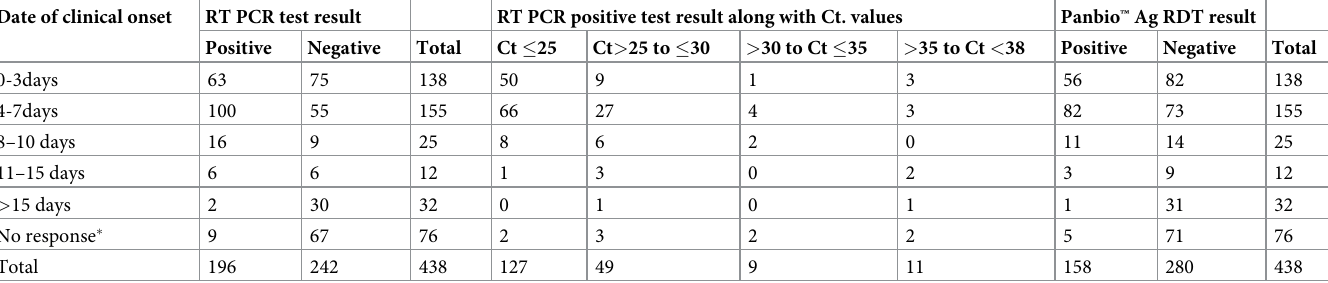
Table 2. RT-PCR and Panbio ™ test results in relation to days since clinical onset, 2021, Addis Ababa, Ethiopia. Date of clinical